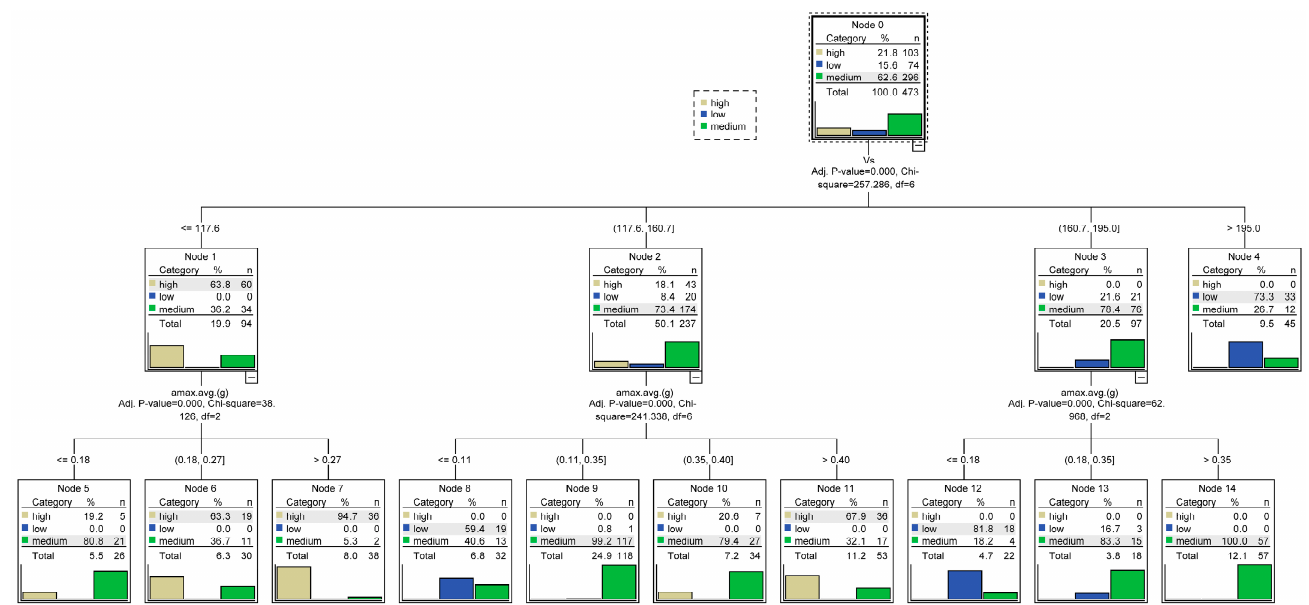
Figure 4. Decision tree for shear wave velocity liquefaction potential grades.